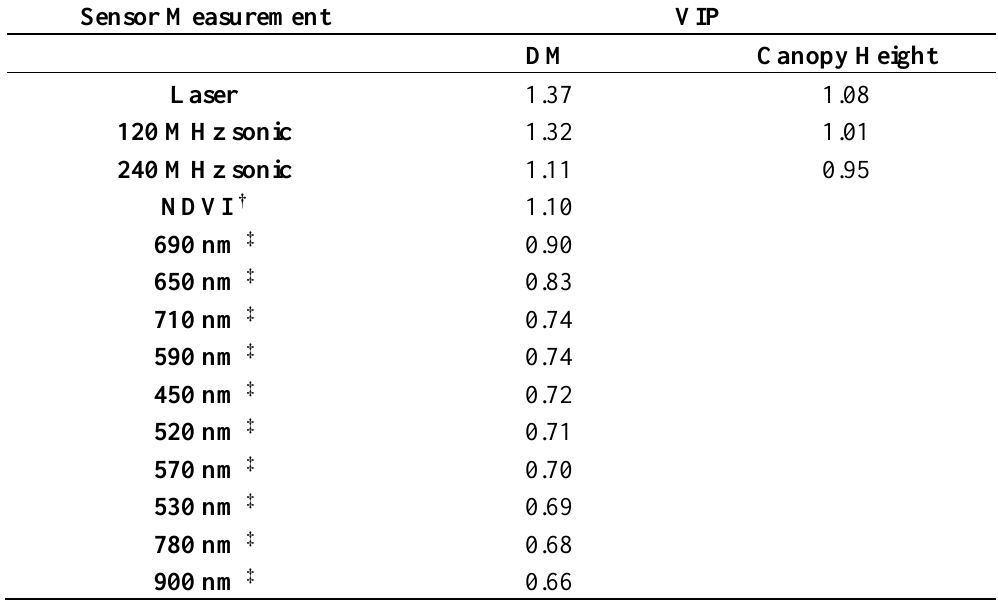
Table 1. Variable Importance Plot (VIP) scores for sensor parameters considered for model inclusion † From Greenseeker ® , ‡ From